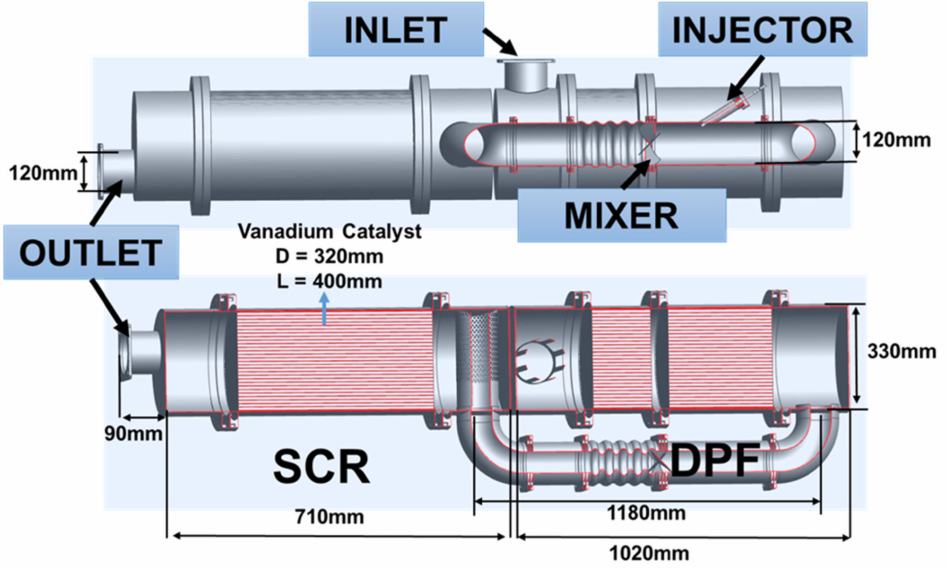
Figure 10. The CFD model for the SCR system (D6CC by Hyundai)